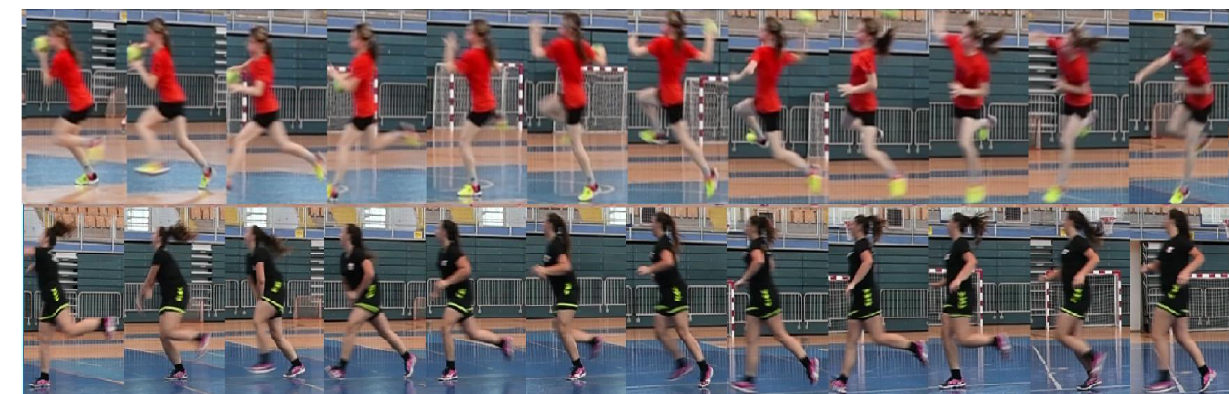
Figure 3. Examples of two candidates of “Jump shot” actions in an annotated time segment.